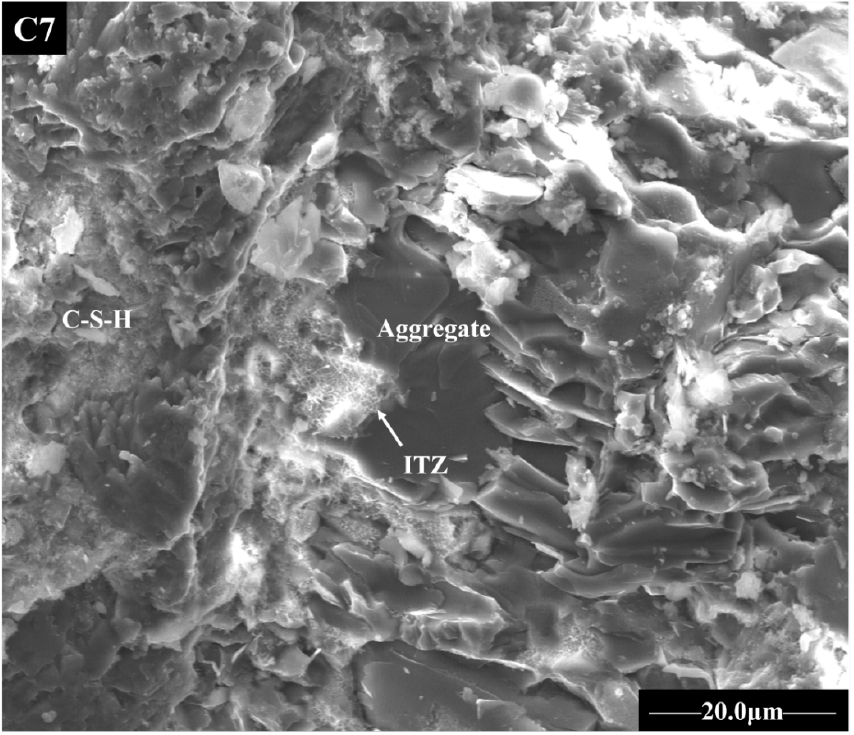
Figure 9. Micromorphology results observed by SEM.